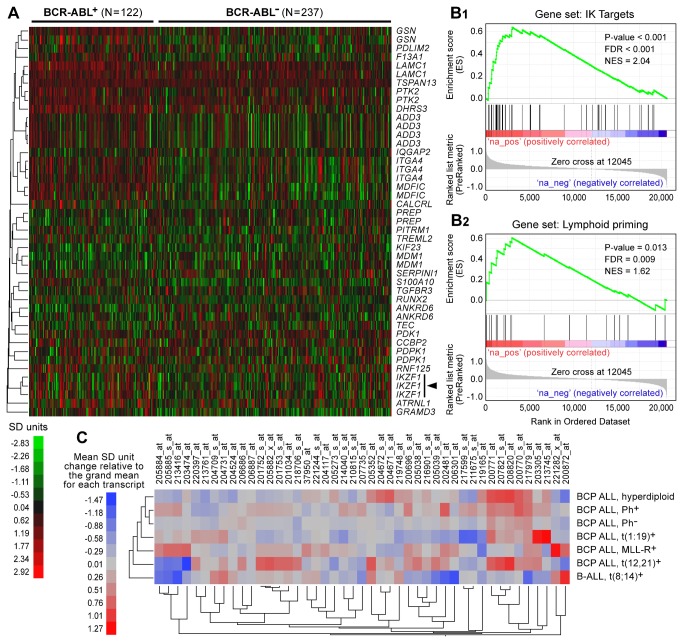
Transcript Levels of Ikaros Target Genes in Primary Leukemia Cells from Pediatric Ph-/BCR-ABL- and Ph + /BCR-ABL+ BPL Patients on the MILE Study.Expression levels of IK target genes were compared between primary leukemic cells (GSE13159) from 122 pediatric BPL patients with t(9;22) translocation (Ph + /BCR-ABL+) and 237 pediatric BPL patients without t(9;22) translocation (Ph-/BCR-ABL-). Heat map depicts up and down regulated transcripts ranging from red to green respectively for standardized expression values and clustered according to average distance metric (A). 25 transcripts representing 16 IK target genes were expressed at significantly higher levels in leukemia cells from Ph+ patients, no significant differences were observed for 10 transcripts representing 9 IK target genes and 7 transcripts representing 5 IK target genes were significantly down regulated (Table S2 in File S1
). Hierarchical cluster analysis identified MDFIC (0.69 SD units, P = 8.8 x 10-12), DHRS3 (0.6 SD units, P = 3.7 x 10-11), GSN (0.49 SD units, P = 3.4 x 10-10), ITGA4 (0.53 SD units, P = 2.6 x 10-9) and TSPAN13 (0.2 SD units, P = 1.2 x 10-7) as the most significantly up-regulated genes in the 122 Ph+ patient samples. Rank ordered difference in standard deviation units for Ph+ samples compared to Ph- samples for enrichment of IK target genes (B1) as well as lymphoid priming genes (B2) using a supervised approach implemented in GSEA2.08 (Broad institute). Enrichment scores were calculated for the ranked members of the gene sets and normalized to the gene set size (NES) for which the p-value was calculated using 1000 permutations of the pre-ranked gene list and the FDR corrected for testing 2 gene sets. There was a significant enrichment of IK target genes (NES = 2.04, P < 0.001) and lymphoid priming genes (NES = 1.62, P = 0.013) that included the leading edge subsets MDFIC, EIF4E3, DHRS3, ITGA4, PTK2, GSN, S100A10, GRAMD3, F13A1, CALCRL, ATP1B1, LAMC1, TES, ADD3, TCTEX1D1, ATRNL1, IL12RB1, RNF125, MCOLN3, RUNX2, PDLIM2, TSGA10, TREML2 for IK targets and IGJ, CNN3, CSF1R, PTGER2, LTB, DNTT, CD52, MEF2C, and RUNX2 for lymphoid priming genes. There was a significant increase in the multivariate mean for 45 transcripts in the Ph+ subset of specimens (MANOVA, F1,357 = 30.65, P<0.0001). The mean level of expression for each transcript in each BPL subset is illustrated in the heat map organized using a two-way hierarchical clustering method (average distance metric) to group expression profiles of transcripts and BPL subsets (C).